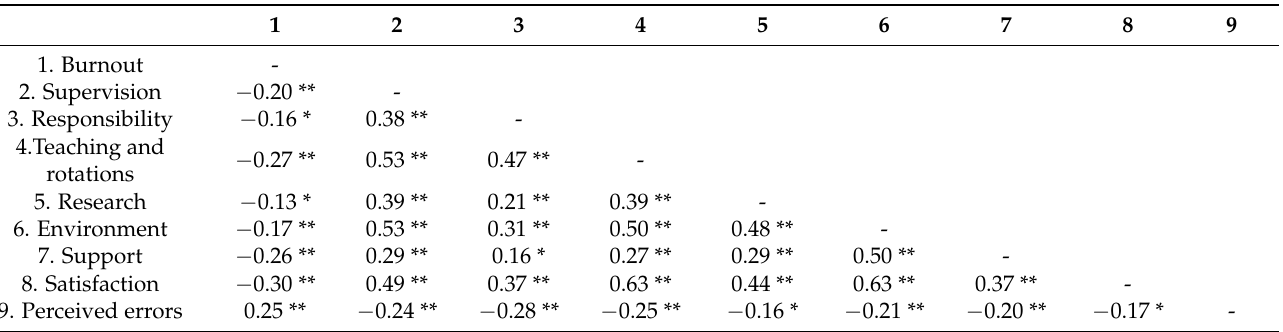
Table 5. Results of the correlations between burnout, work-related factors and perceived